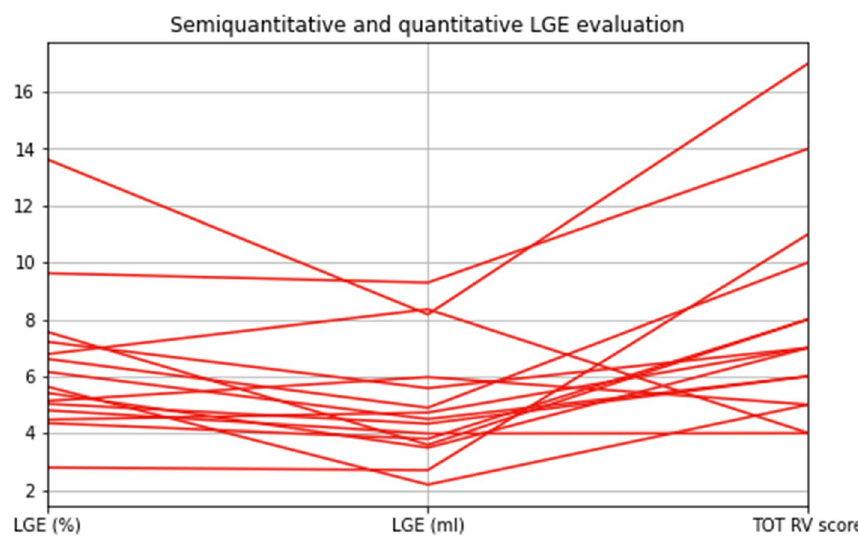
Fig. 3 Relations among right ventricular (RV) late gadolinium enhancement (LGE) quantitative and qualitative estimates, represented by percentage over the left ventricle (%), volume (mL), and the total LGE score (TOT RV score) as proposed by Babu-Narayan et al. [9]